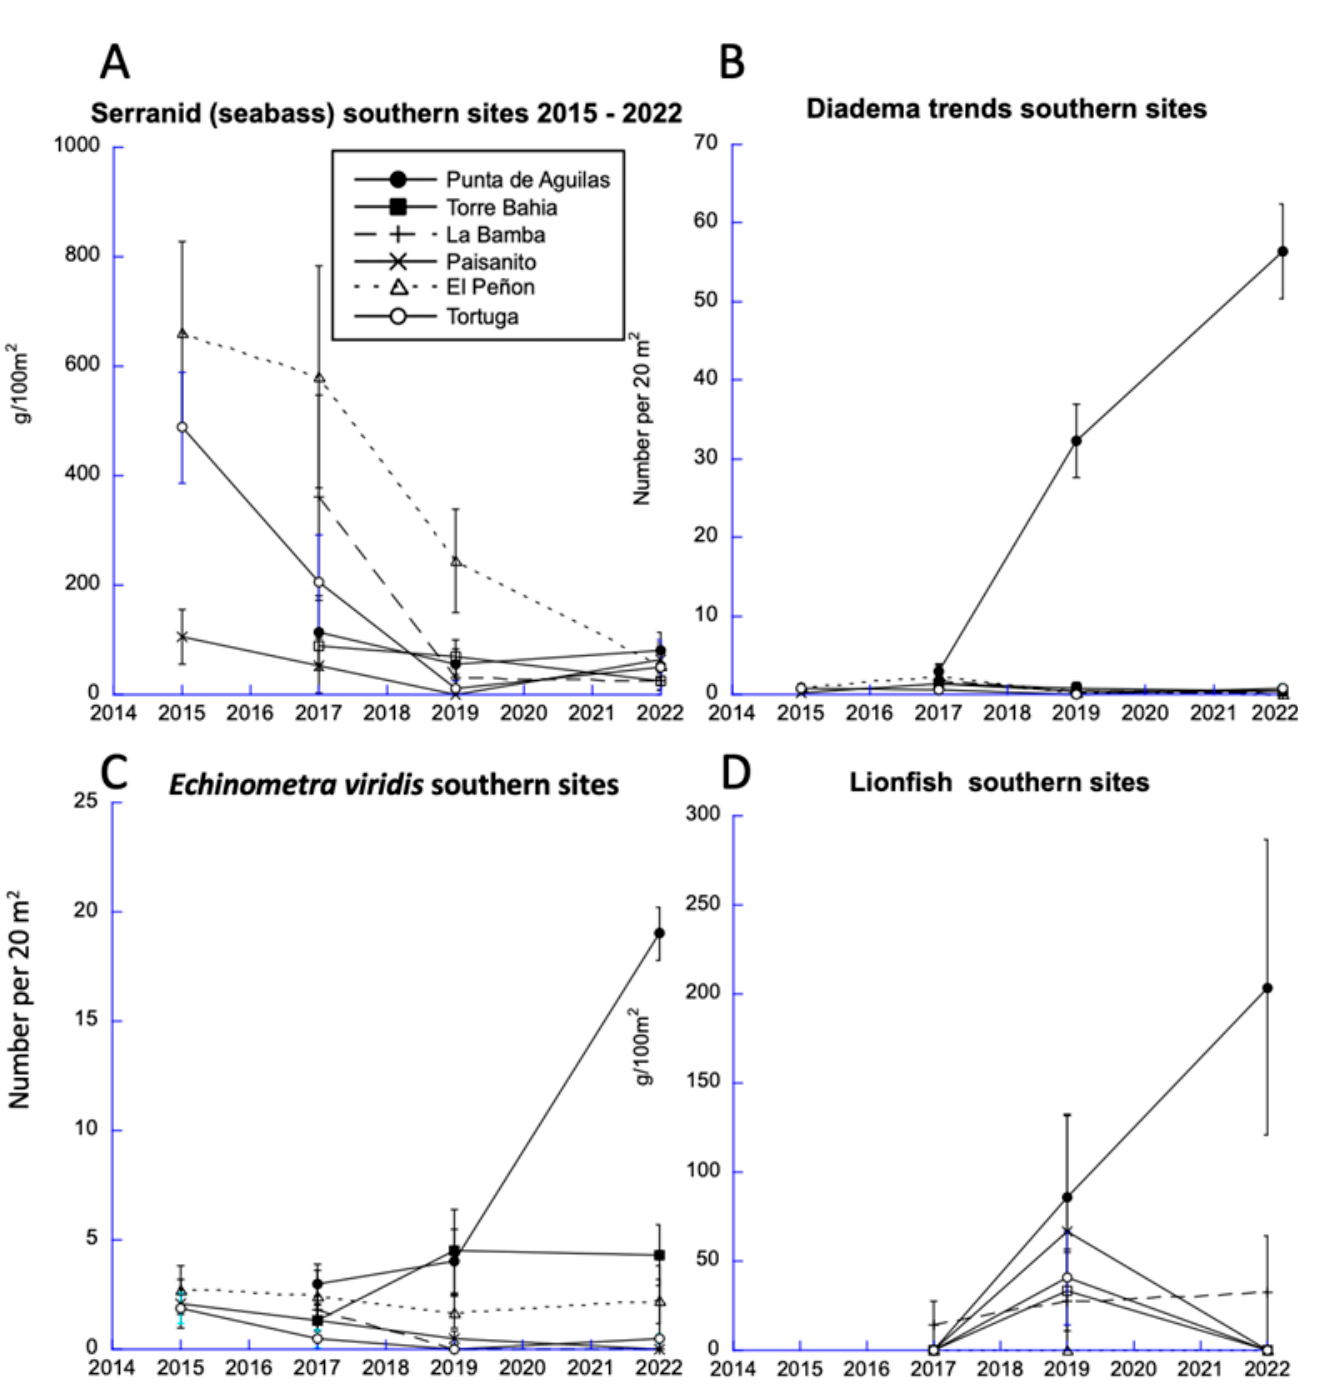
Figure 11. Trends in seabass (Serranidae such as groupers, coney, and graysby) abundance and their potential prey across all years: ( A ) changes in seabass abundance for all southern sites (note that Punta Aguilas had low seabass abundance all years of monitoring), and ( B , C ) Diadema and Echinometra viridis and ( D) lionfish.